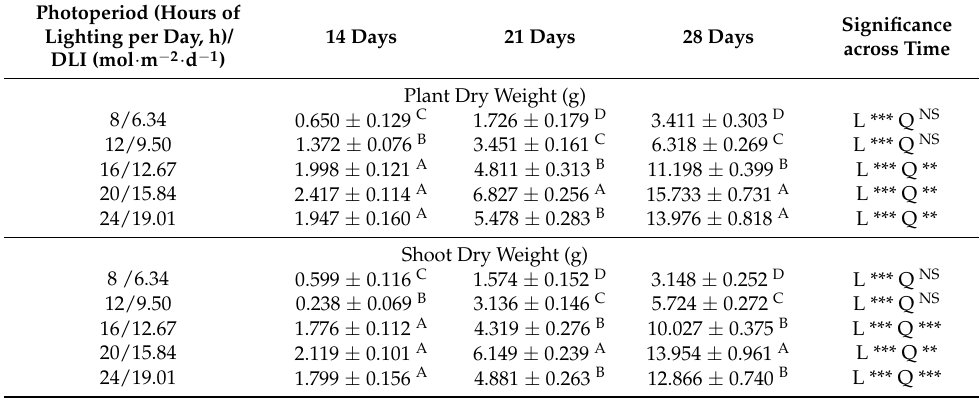
Table 2. Mean plant dry weight, shoot dry weight, root dry weight, and shoot:root ratio of ice plant in response to photoperiod/daily light integral (DLI) treatment over time (plants harvested 14, 21, or 28 days after treatment). Data represent means ( ± SE) of 3 experimental units times 3 replications over